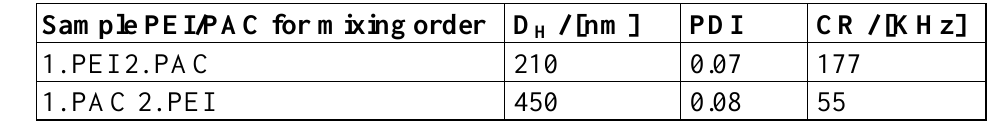
Table 1. Dynamic light scattering (DLS) parameters hydrodynamic diameter (D polydispersity index (PDI) and count rate (CR) obtained for PEC-0.6 dispersions of